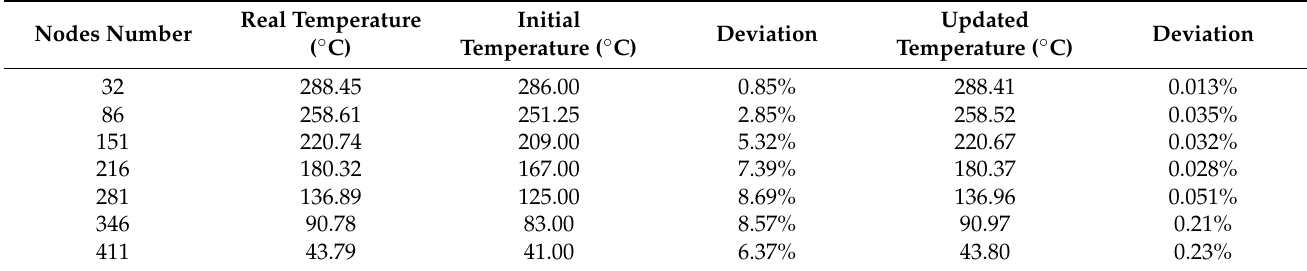
Table 6. The comparison among real temperature, initial temperature and updated temperature.